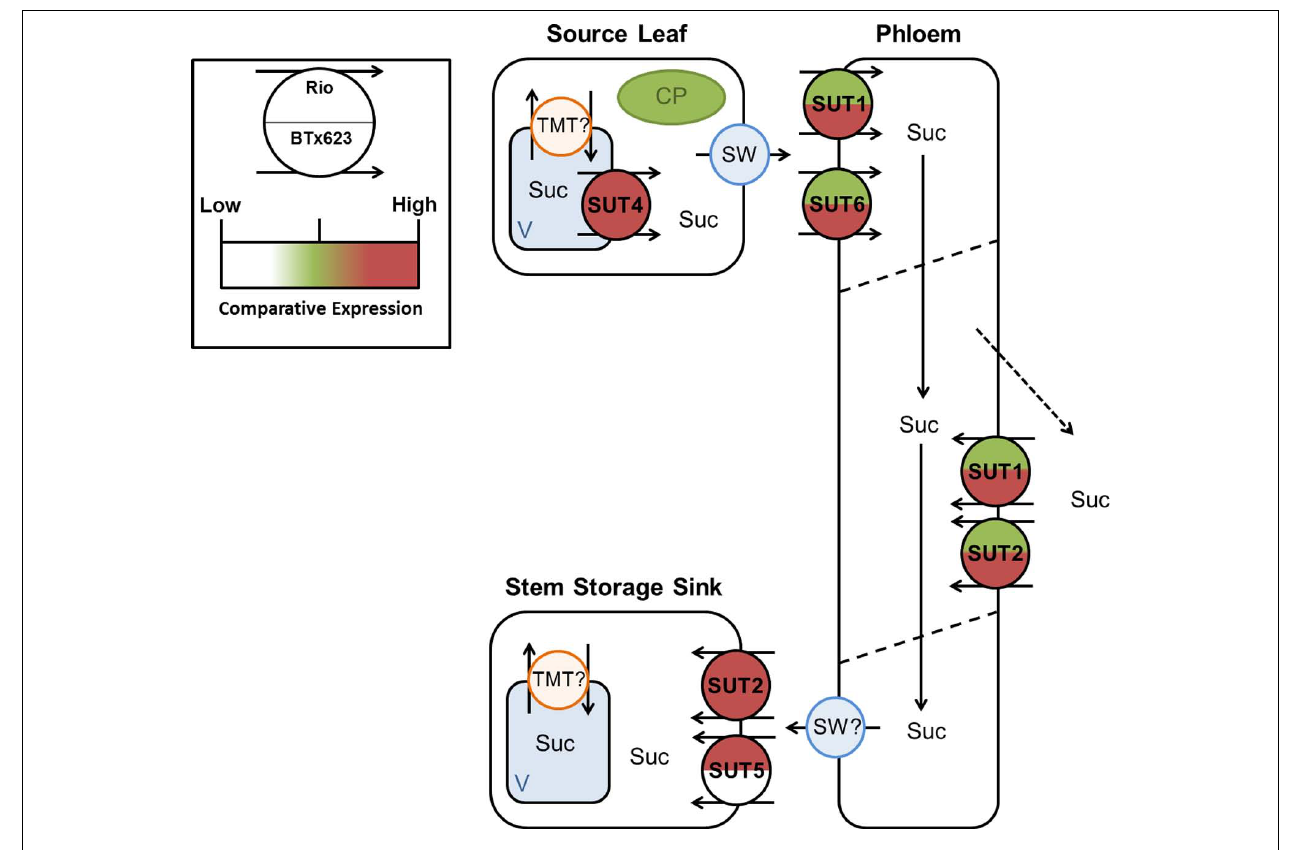
FIGURE 8 | Predicted source–transport–sink pathway in Sorghum during vegetative growth. Sucrose is released from source vacuoles (V) by SbSUT4. SbSUT1 and SbSUT6 load the phloem. SbSUT1 and SbSUT2 may act to retrieve sucrose leaked from the transport phloem. SbSUT2 and